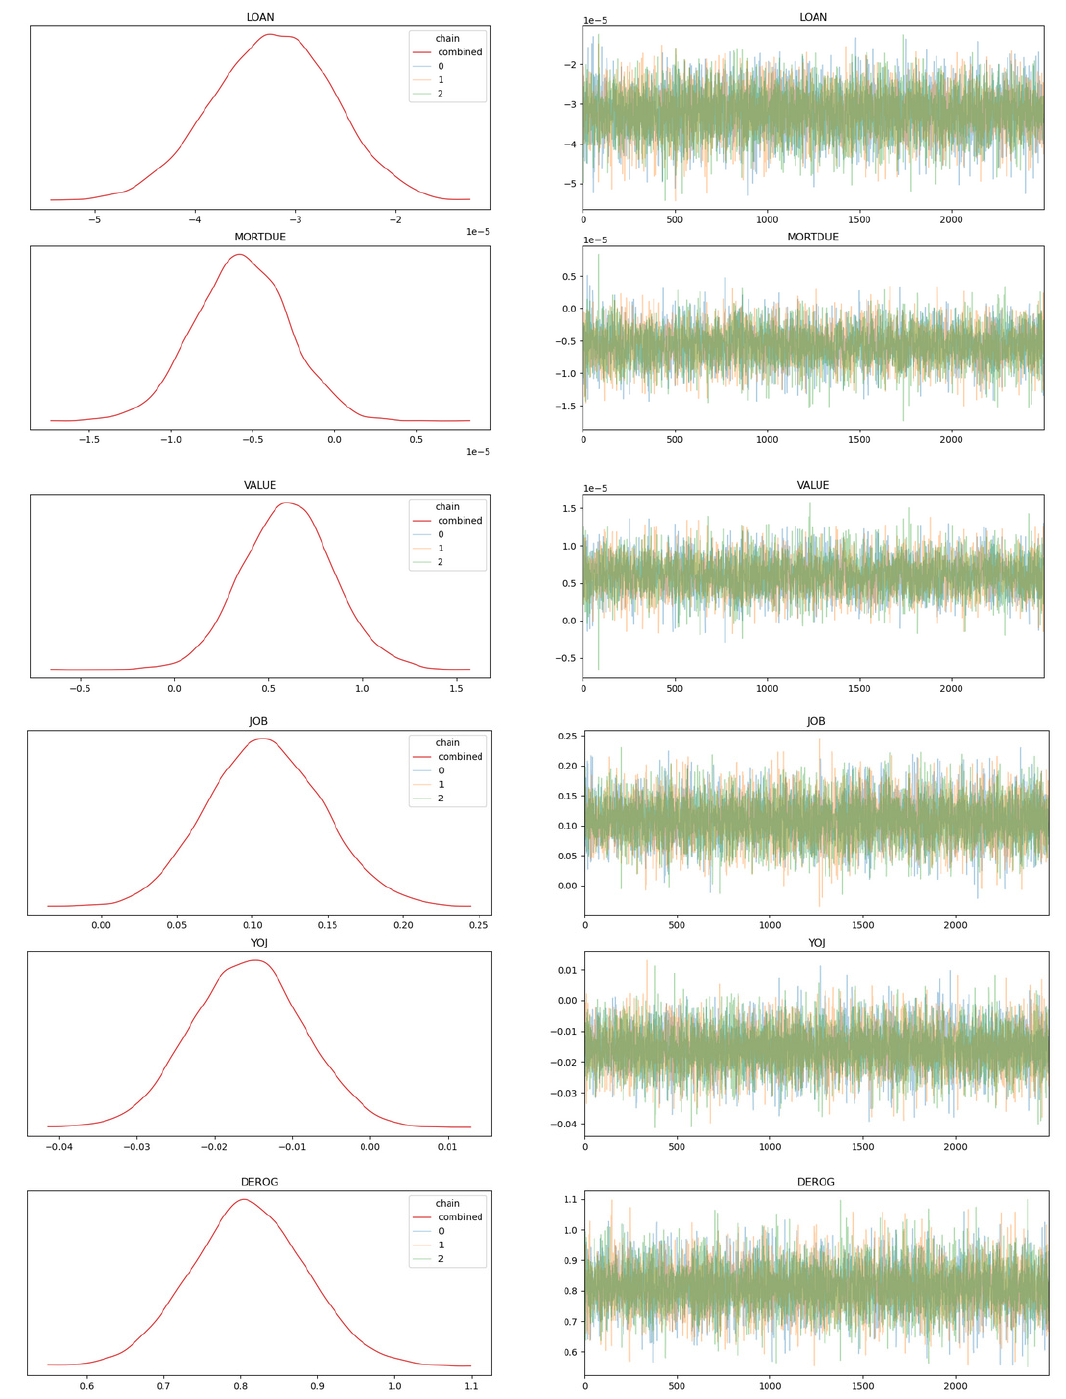
Figure 5. Visual inspection of sampling from posterior.